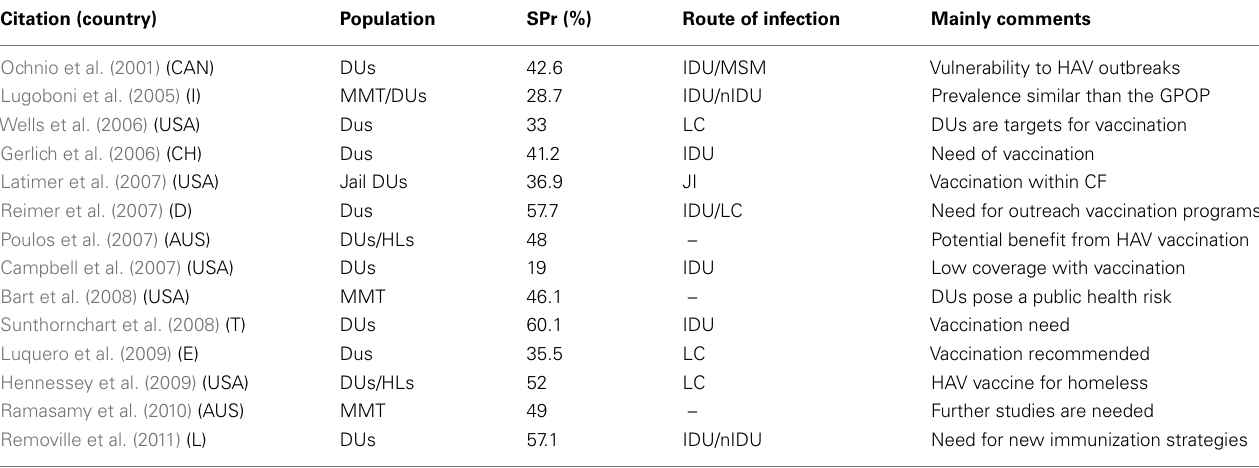
Table 1 | HepatitisA virus: sero-epidemiological data among